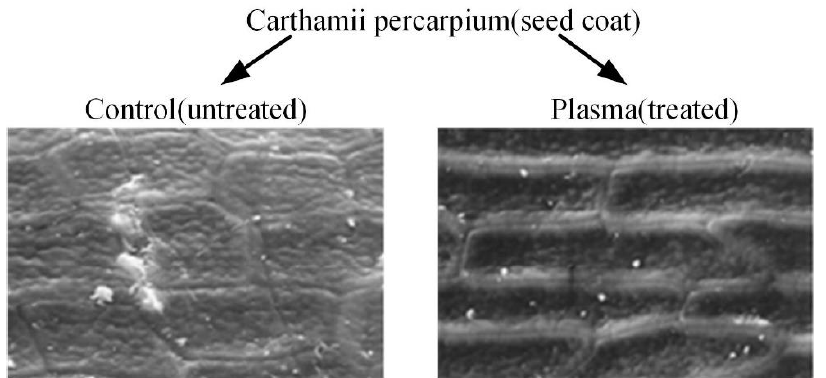
Figure 3. Seed germination processed by a high-voltage electrostatic field. Reprinted with permission from ref. [43]. Copyright 2006